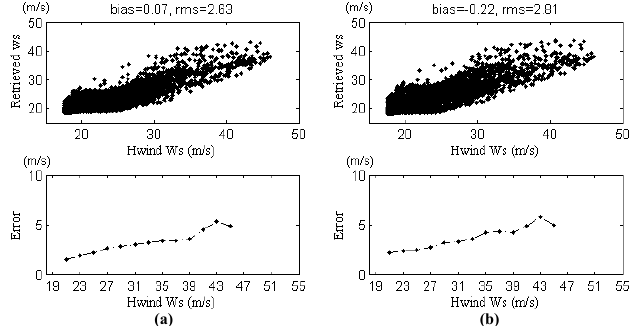
Figure 7. Retrieved wind speed of three hurricanes using our new method and the Shibata method with the new coefficients versus H*wind analysis data. ( a ) Our new method and ( b ) the method of Shibata (2006) with the new coefficients.